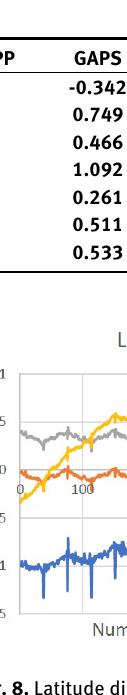
Table 1. Results about latitude differences (Agisoft) (m).